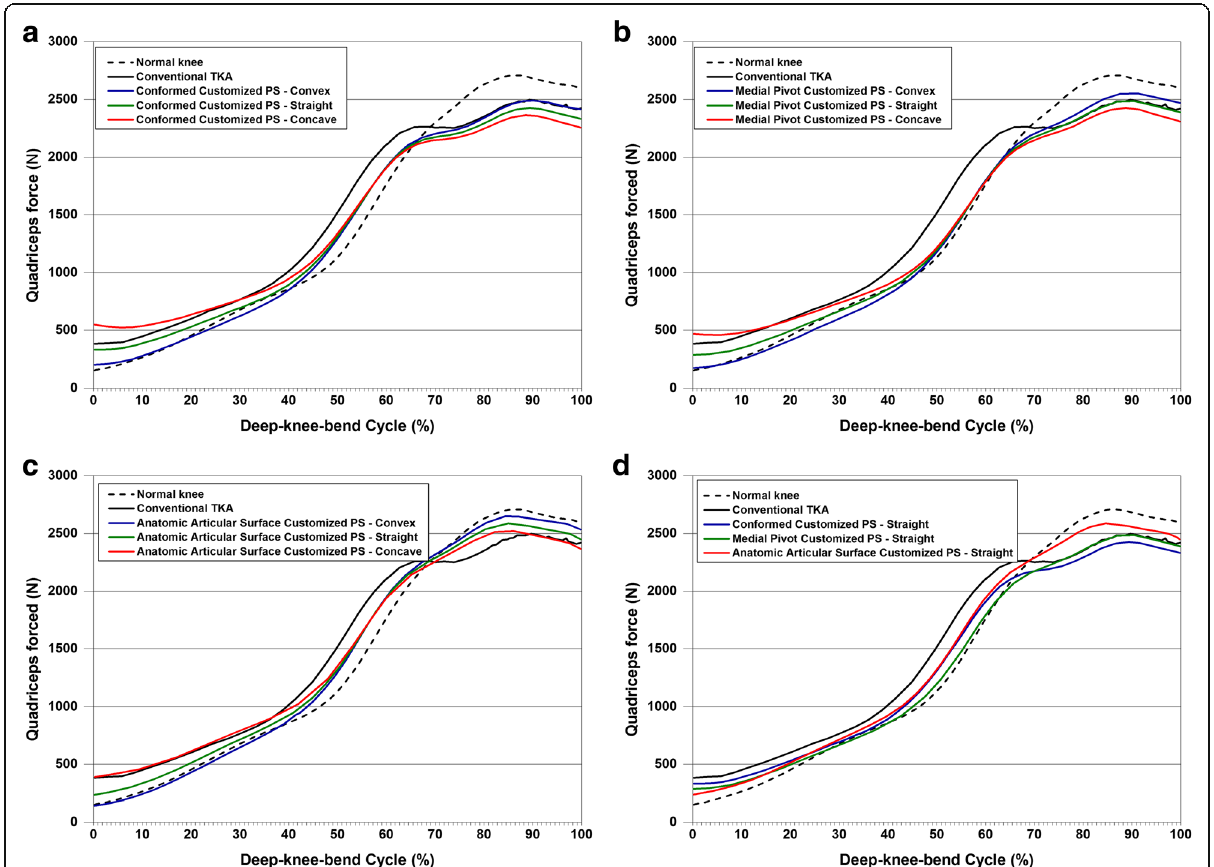
Fig. 8 Comparison of quadriceps force in ( a ) Conformed Customized PS-TKA, ( b ) Medial Pivot Customized PS-TKA, and ( c ) Anatomic Articular Surface Customized PS-TKA with regard to different cam designs in the tibial component and ( d ) straight post designed tibial component with regard to different conformity designs in the tibial component under